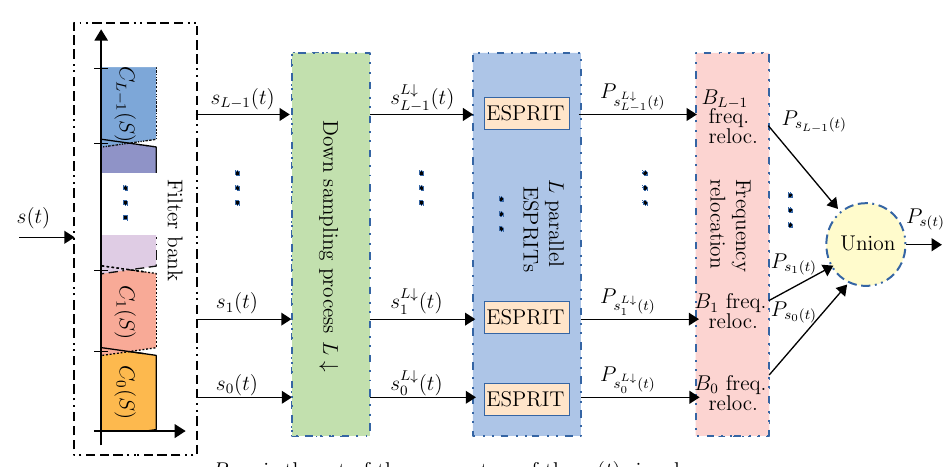
Figure 3. The filter bank associated ESPRIT block